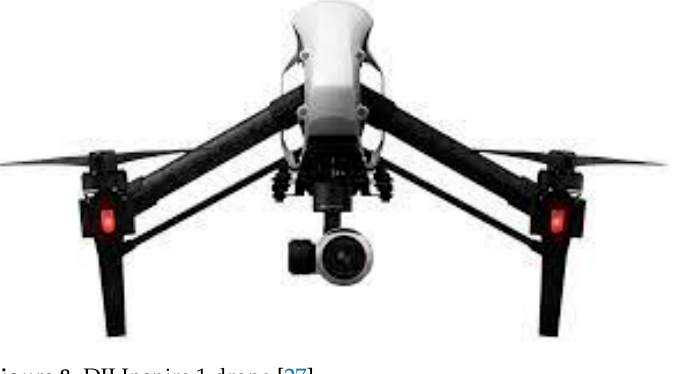
Figure 8. DJI Inspire 1 drone [27].